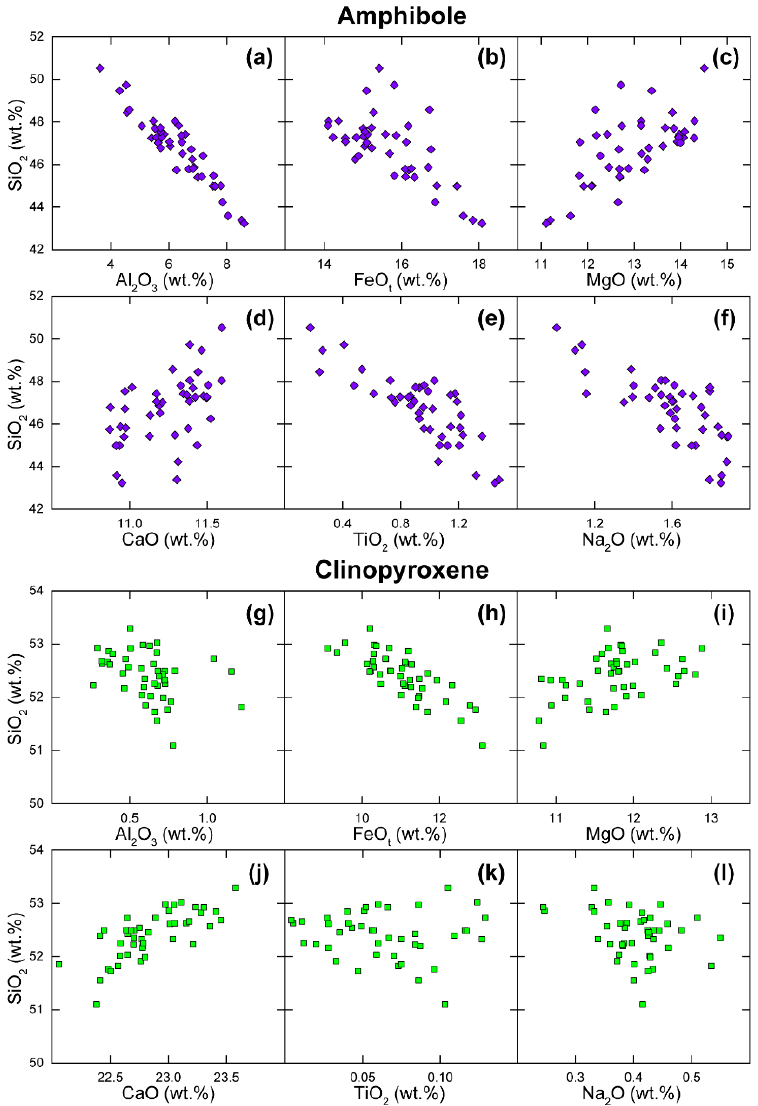
Figure 9. Harker diagrams show the major compositions of amphibole ( a – f ) and clinopyroxene ( g – l